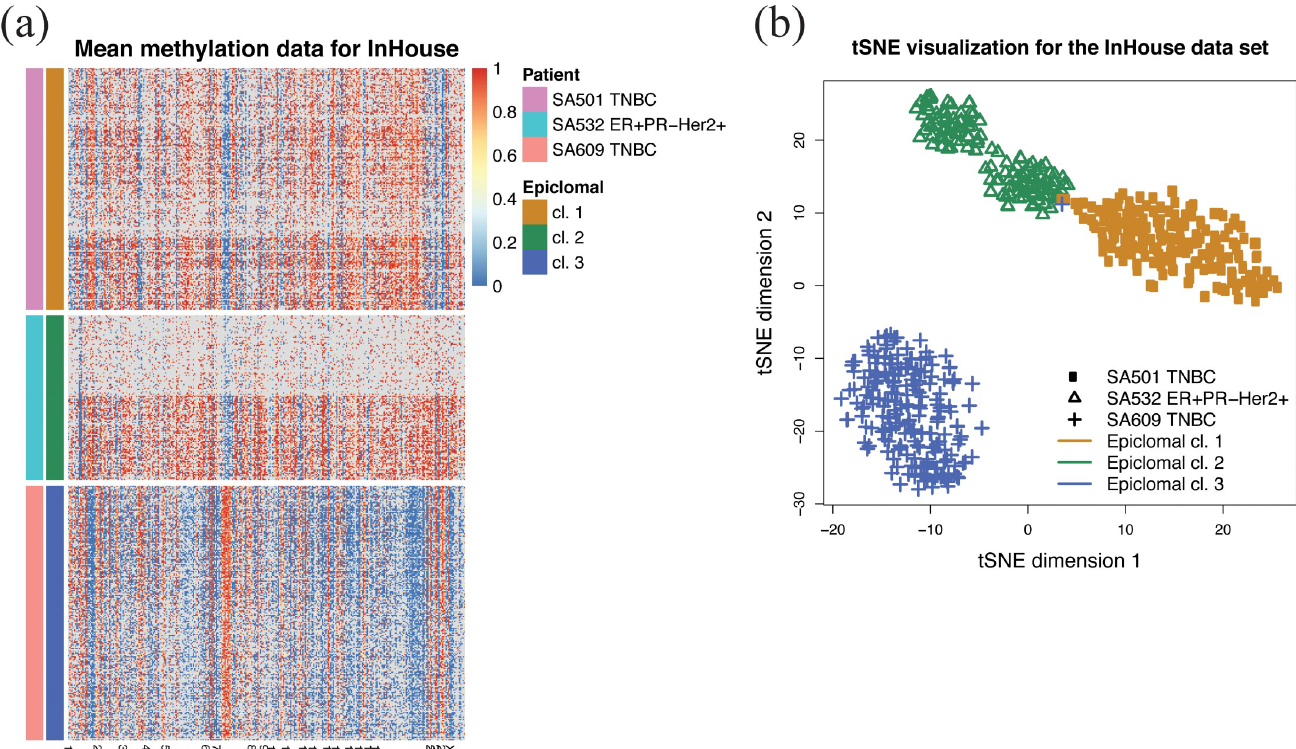
Fig 7. Visualization of the InHouse clusters. (a) EpiclomalRegion clustering, with data filtered to include the most variable CGIs and obtain � 15,000 loci (327 CGIs, cell average missing proportion 0.82, 558 cells). EpiclomalRegion obtained 3 clusters. Rows are cells, and columns are CGIs. (b) tSNE dimensionality reduction and color-coding of the Epiclomal clusters onto the tSNE 2-dimensional